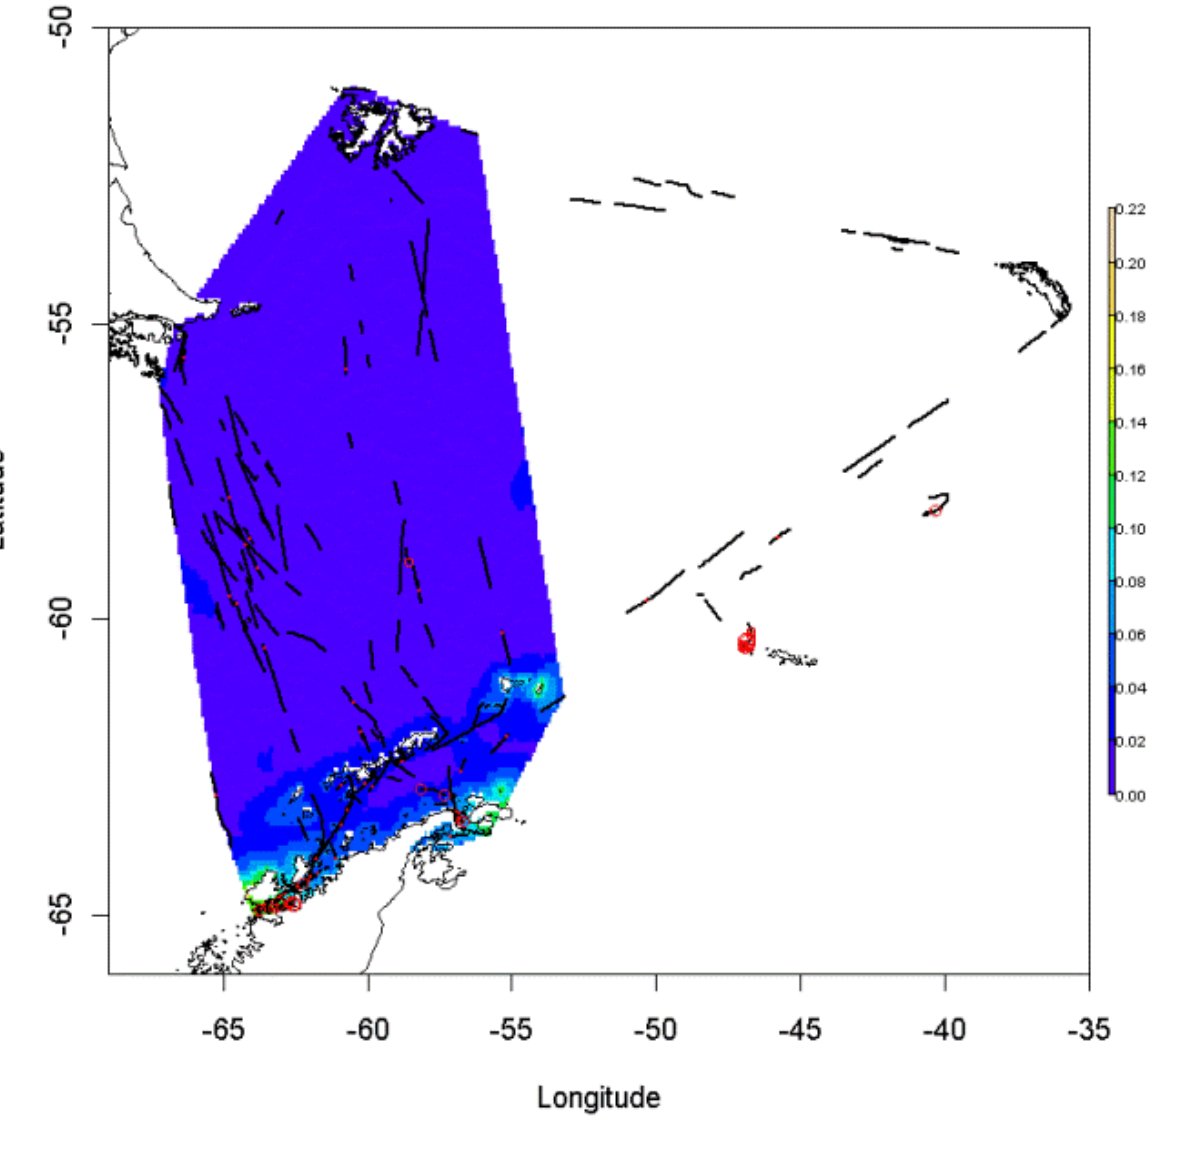
Fig. 6. Predicted density gradient of minke whale schools in the best-covered region of the study area. The scale bar on the right is in units of schools per nm 2 . Tracklines are shown as solid black lines, and minke sightings are shown as red circles with radius proportional to school